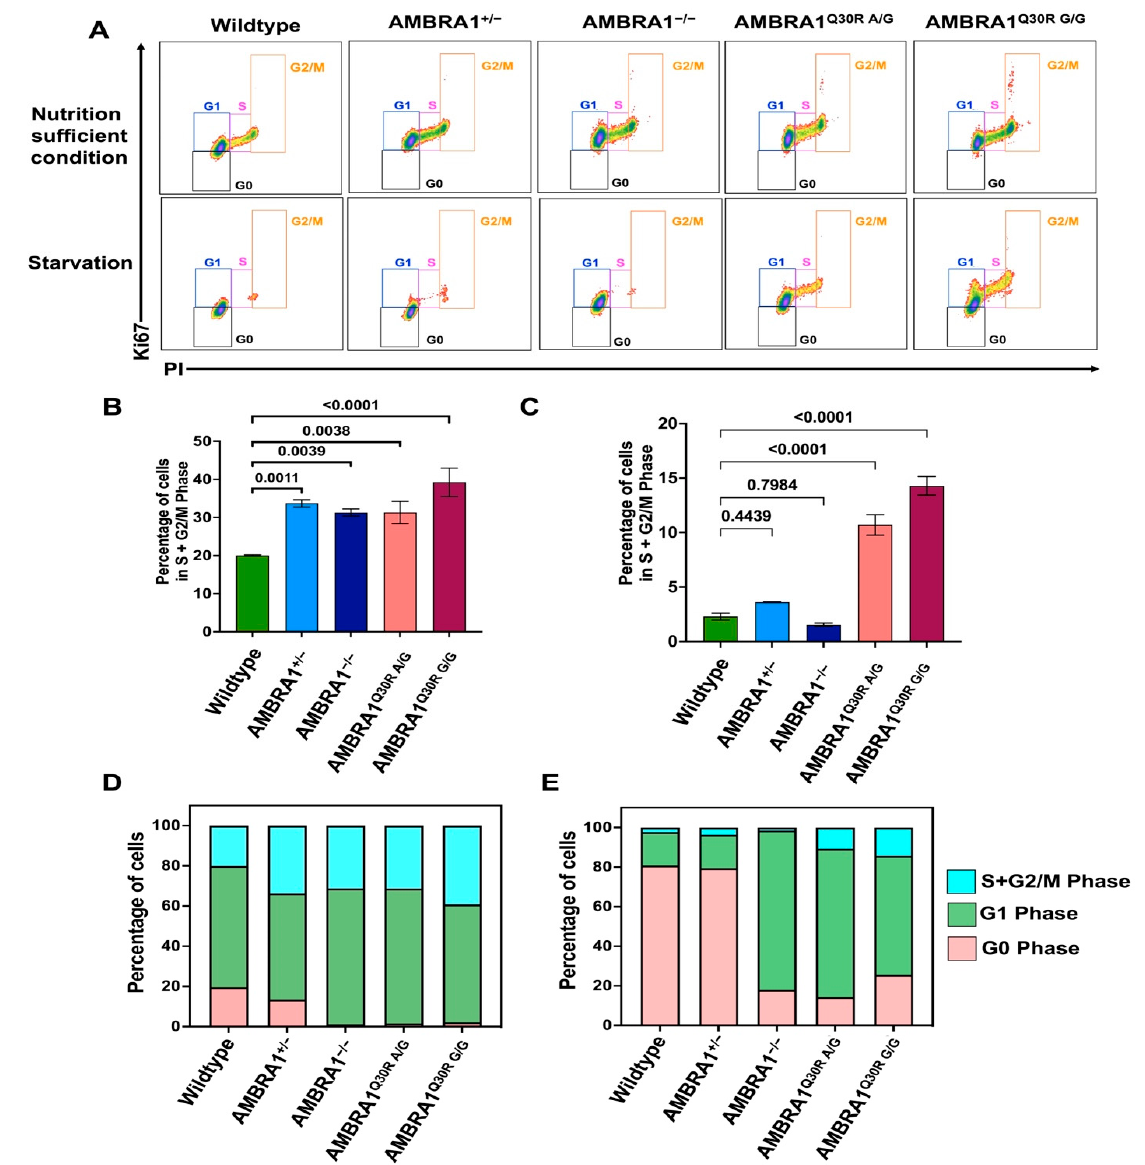
Figure 2. AMBRA1 deregulation dynamically altered the cell cycle arrest in hTERT-RPE1 cells. ( A ) Flow cytometry analysis of AMBRA1 -altered hTERT-RPE1 cells. Cells were stained with Ki67, a cell proliferation marker rarely detected in the non-dividing G0 phase and highly expressed in proliferating cells (maximum in the G2 and early M phases), and PI, a DNA marker, staining proportionally to the DNA content of the cell. Staining cells with both Ki67 and PI successfully differentiated each cell cycle phase, represented in boxes of different colors (G0—black; G1—blue; S—pink; G2/M—orange). Analysis was performed in triplicate. A representative graph for each genotype is shown. ( B ) Bar graph representing the percentage of AMBRA1 -depleted and Q30R mutant hTERT-RPE1 cells distributed in the S+G2/M phase under nutrient-sufficient conditions, calculated from the flow cytometry result (A, top). Statistical significance was determined by ANOVA. ( C ) Bar graph representing the percentage of starved AMBRA1 -depleted and Q30R mutant hTERT-RPE1 cells distributed in the S+G2/M phase, calculated from the flow cytometry result ( A , bottom). Statistical significance was determined by ANOVA. ( D ) Stacked bar graph representing the percentage of AMBRA1 -depleted and Q30R mutant hTERT-RPE1 cells distributed in different cell cycle phases under nutrient-sufficient conditions. ( E ) Stacked bar graph representing the percentage of starved AMBRA1 -depleted and Q30R mutant hTERT-RPE1 cells distributed in different cell cycle phases.